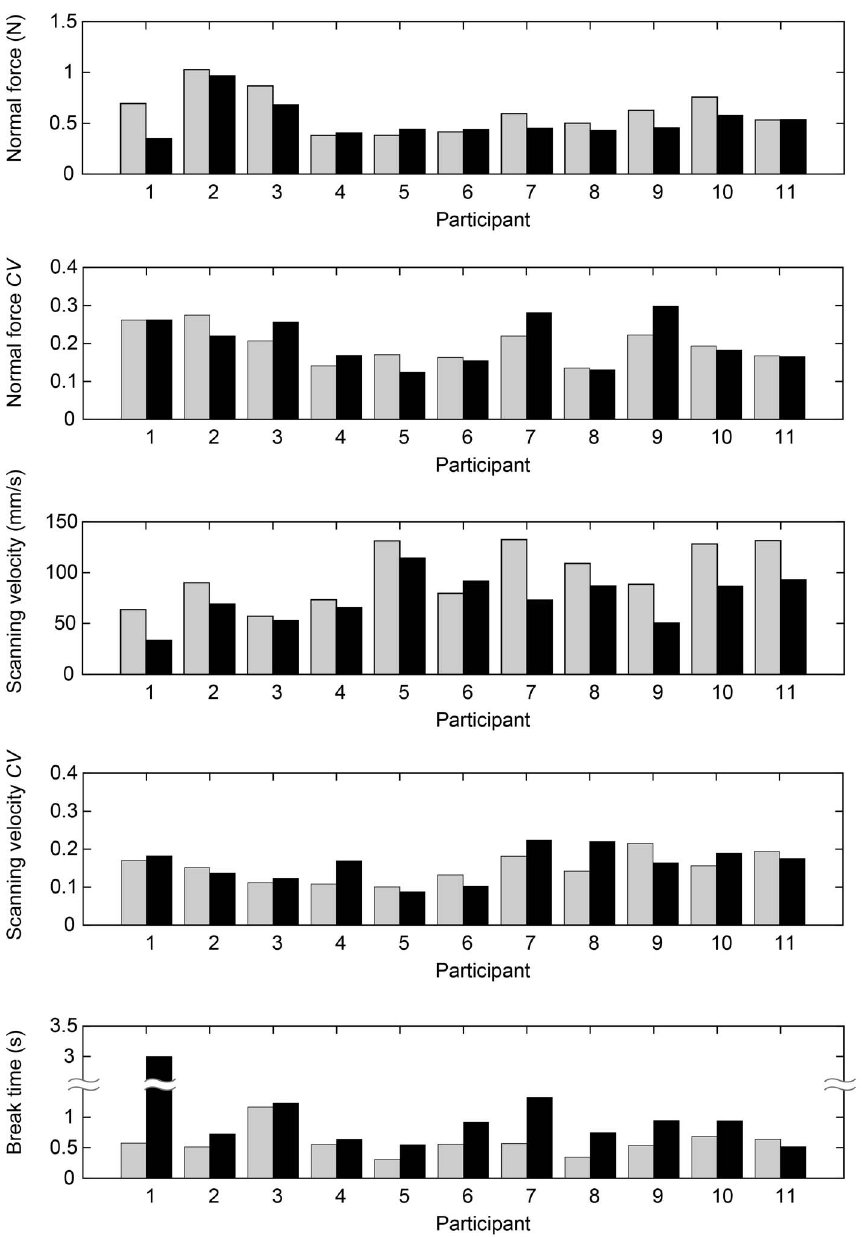
Figure 6. Averages of each parameter for data collected in perceptual tasks for each participant. Gray bars indicate averages in the discrimination task and black bars indicate averages in the identification task.